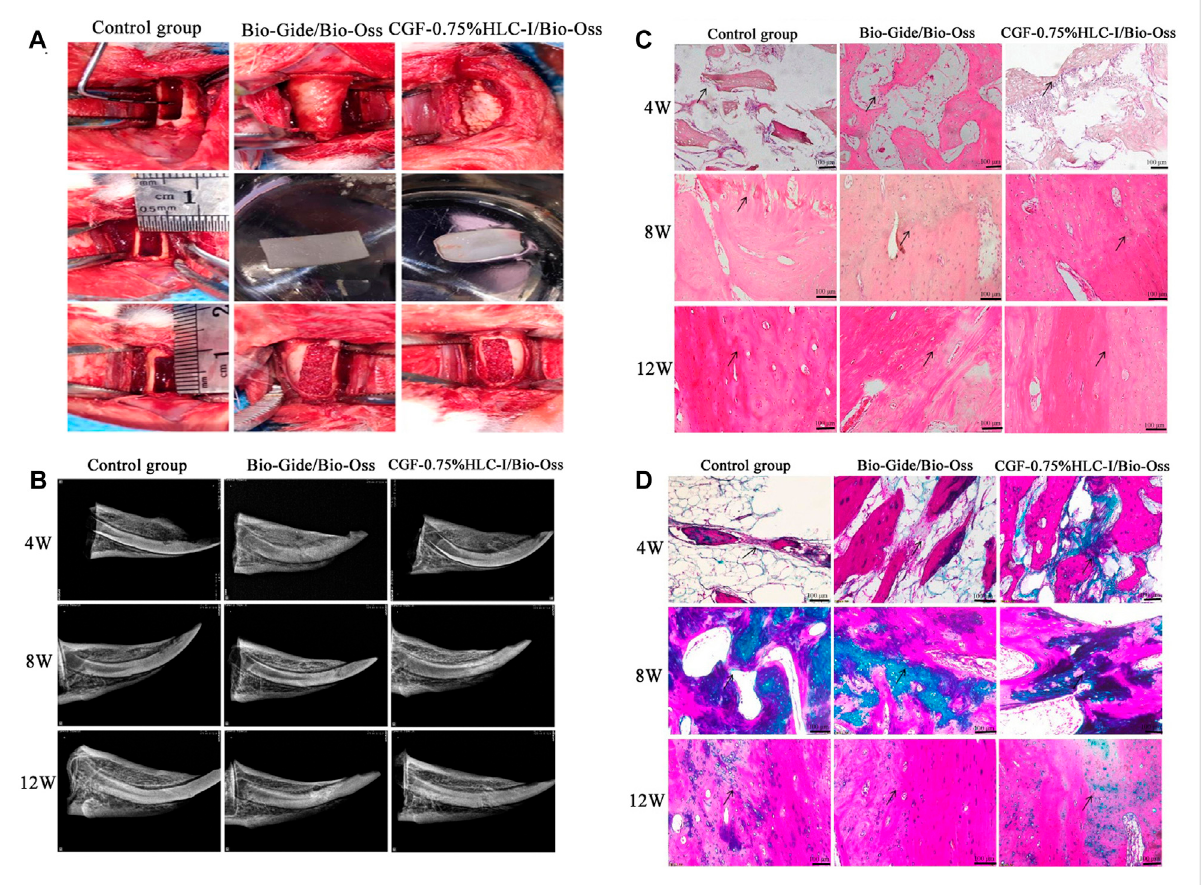
Figure 8C showed the volcano plot of DEPs in group C compared to group B. Figure 8D showed the heat map of DEPs in the ratio of group C and group. Statistical analysis selected 8 DEPs with statistical signi fi cance, including 3 up-